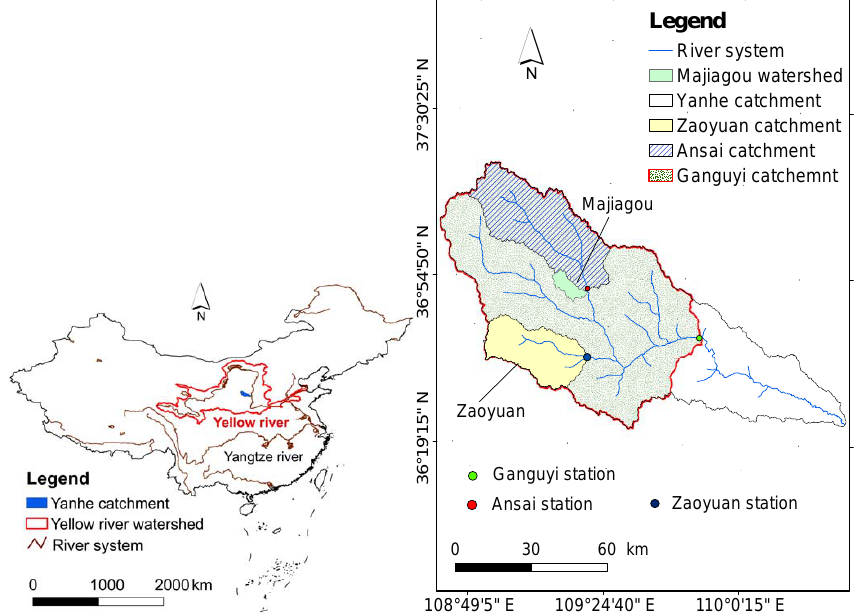
Figure 1. The relative location between the Yanhe River watershed and the Yellow River/Yellow River basin, the geographical location sketch of the Majiagou River watershed, the Zaoyuan upstream catchment, the Ansai upstream catchment, and the Ganguyi upstream catchment in the river system of the Yanhe River